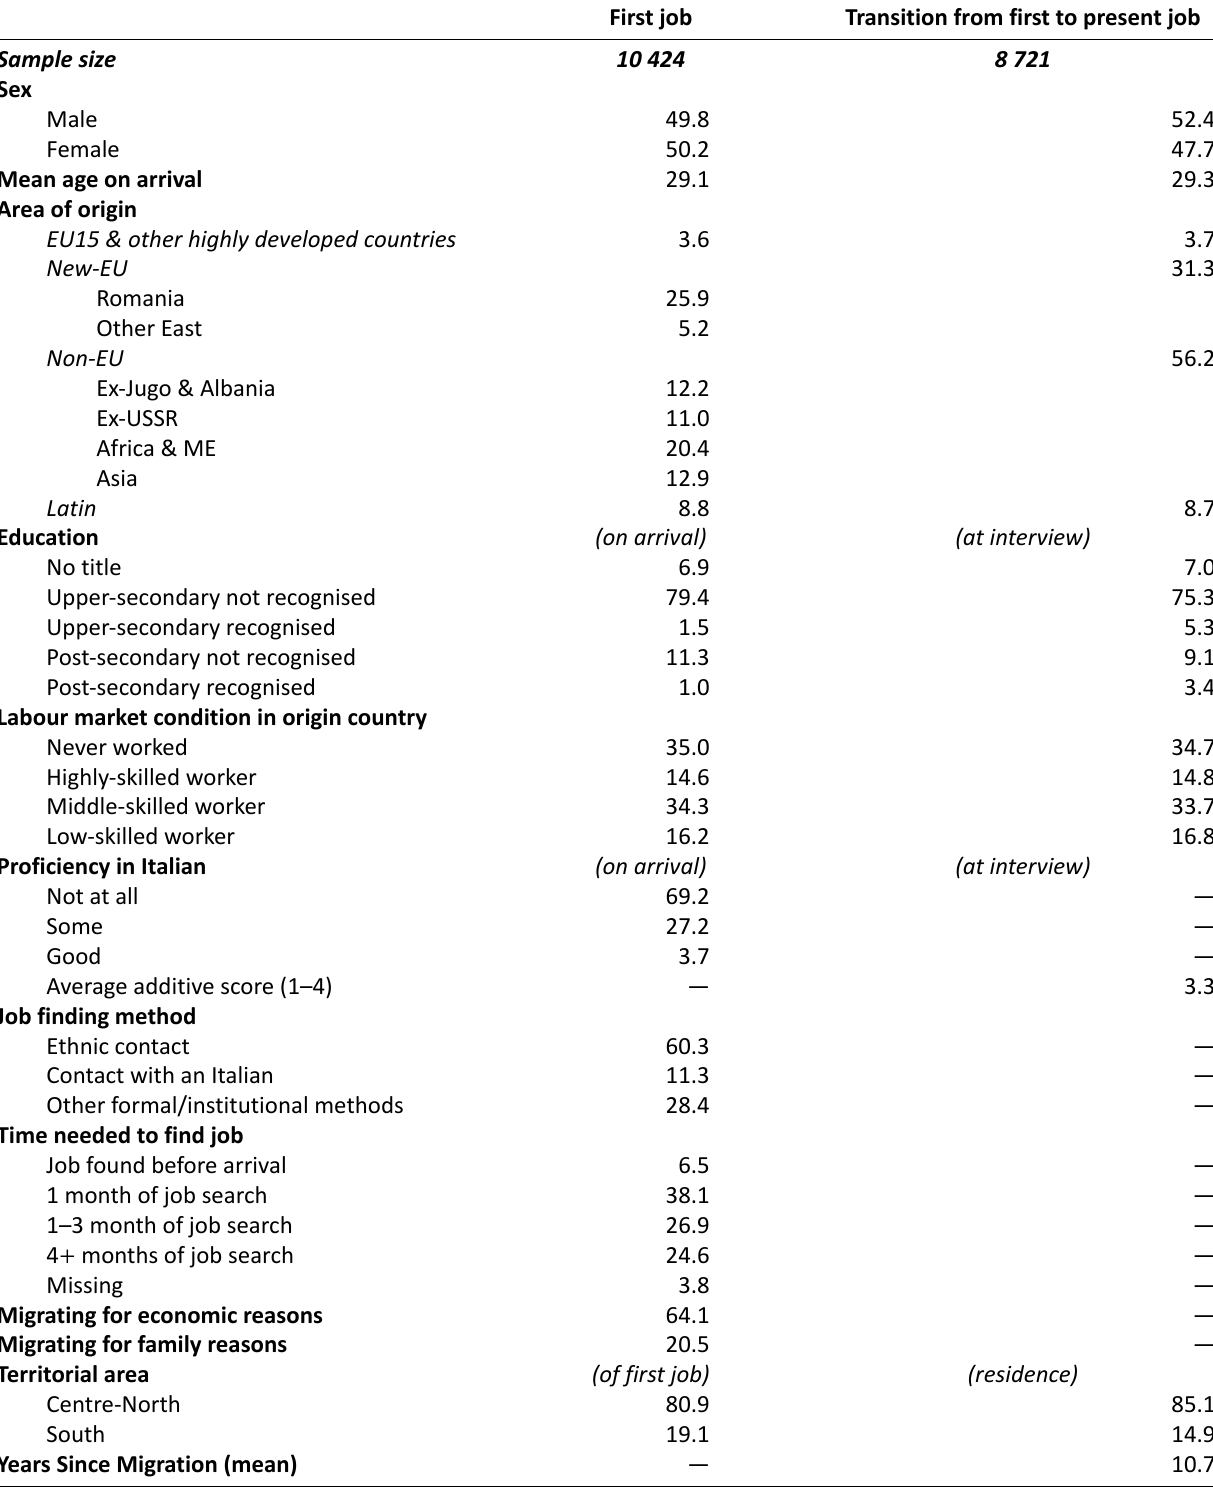
Table A1. Descriptive statistics of samples for Model 1 (ISEI first job) and Model 2 (Change in